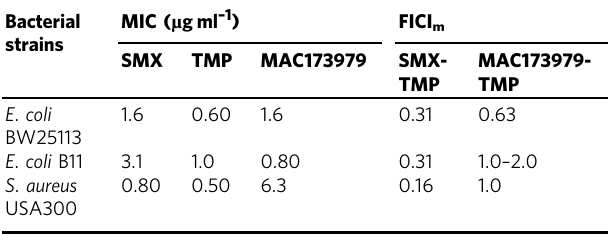
Fig. 1 Synergistic activity of anti-folate combinations against E . coli and S . aureus . a Targets of anti-folate compounds. b – d E . coli BW25113 strain was